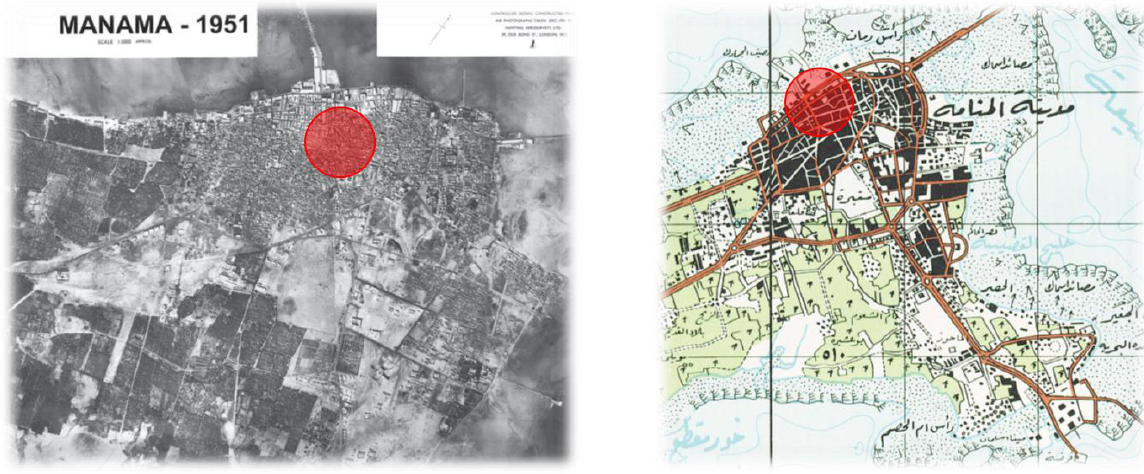
Figure 6 : Topographic Map of Manama 1951. Figure 7: Topographic Map of Manama 1930 (Al-Nabi, The History of Land use and Development in Bahrain, 2012)